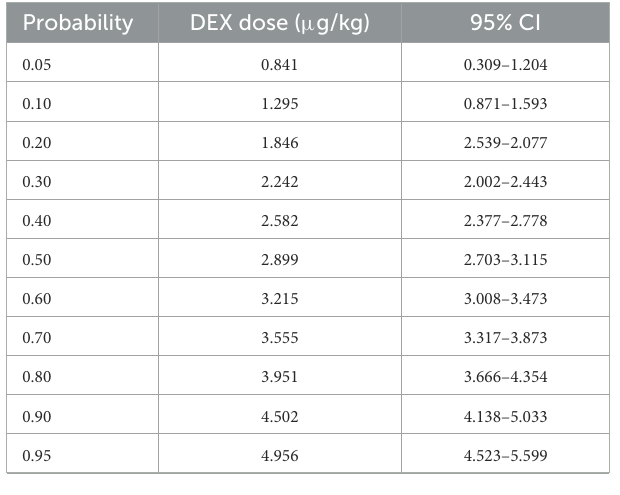
TABLE 2 Calculated probabilities of loss of consciousness.